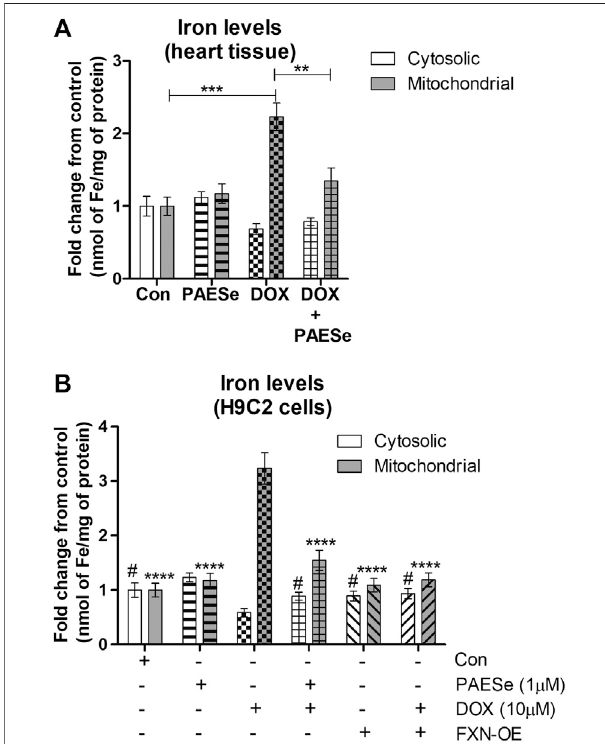
FIGURE 4 | PAESe protects against DOX mediated mitochondrial iron accumulation. (A) Ferrozine assay from heart tissue. Mitochondrial and cytosolic fractions were partitioned from heart tissues collected from control and drug-treated nude mice that were imaged by MRI in Figure 1 . Groups were divided as the following: Control (saline), DOX (25 mg/kg/Dose), PAESe (10 mg/kg/dose) and DOX + PAESe (25 mg/kg/dose+50 mg/kg/ dose) as indicated in the methods section. Animals were administered drugs once a week (Q.I.W.), and the dosing stopped at the 4th week, followed by two weeks of recovery. (* p < 0.05,** p < 0.001, *** p < 0.0001; Mean ± SEM, n (cid:2) 4miceper group). Mitochondrialand cytosolicironlevelsweremeasured by Ferrozine colorimetric assay. (B) Free iron (Fe 2+ / 3+ was measured by a Ferrozine colorimetric assay based upon a previously published technique (Riemer et al., 2004), from mitochondrial and cytosolic H9C2 subcellular fractions. Cells were treated with DOX (10 µM) with or without PAESe (1 µM) for 24 h (* p < 0.05,** p < 0.001,*** p < 0.0001vs Control; Mean ± SEM, N (cid:2)